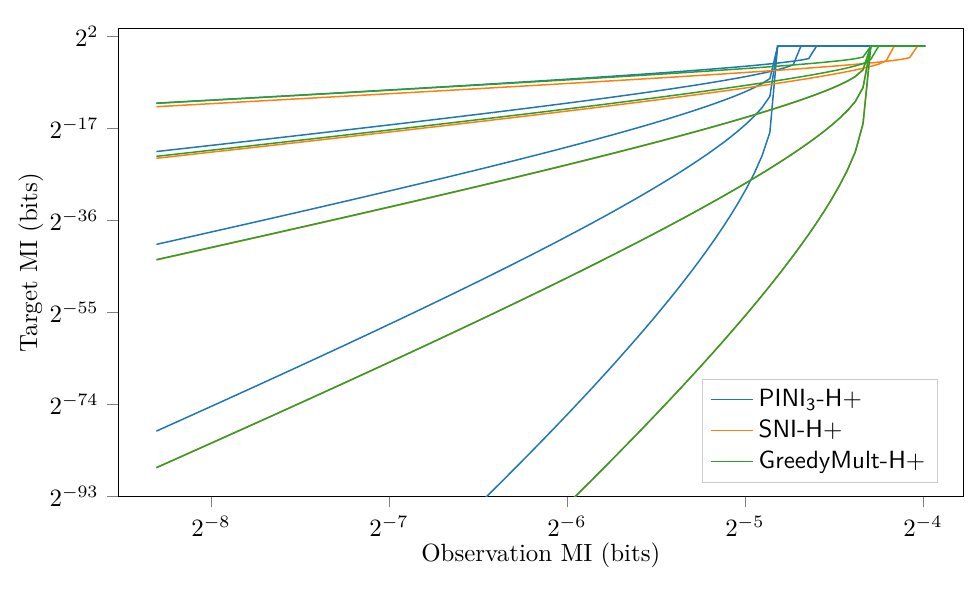
Figure 8: Target MI as a function of observation MI, for the SNI-H+ , PINI 3 -H+ and GreedyMult-H+ multiplication gadgets at orders t = 1 , 3 , 7 , 15 , 31. The curves for SNI-H+ and GreedyMult-H+ are superimposed for t ≥